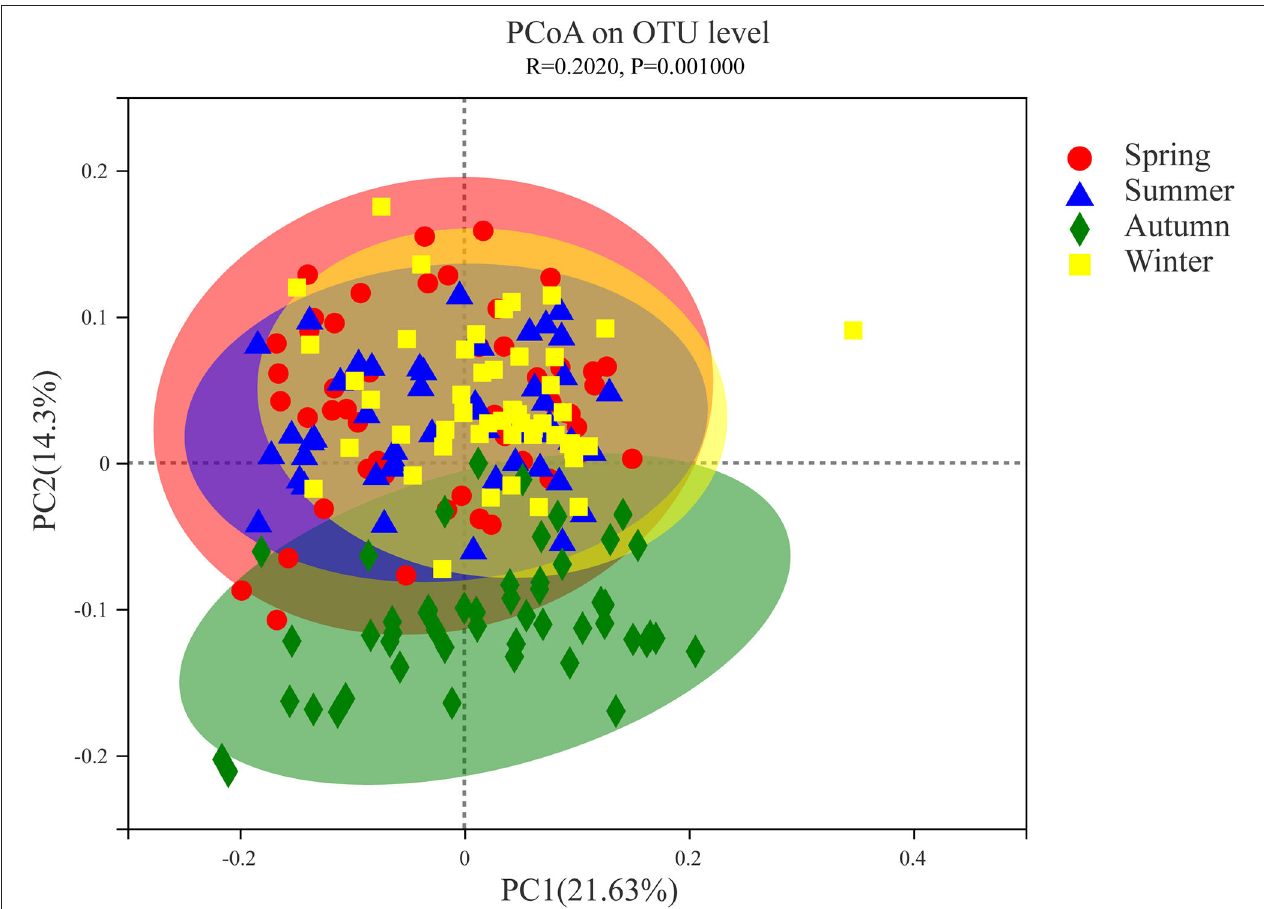
FIGURE 3 | Principal coordinate analysis (PCoA) of fecal microflora of Chinese merino fine-wool Sheep in different seasons. PCoA was calculated from the weighted UniFrac metrics. Each point represents a single microbiota sample obtained from Spring (red circle), Summer (blue triangle), Autumn (green diamond), and Winter (yellow square)